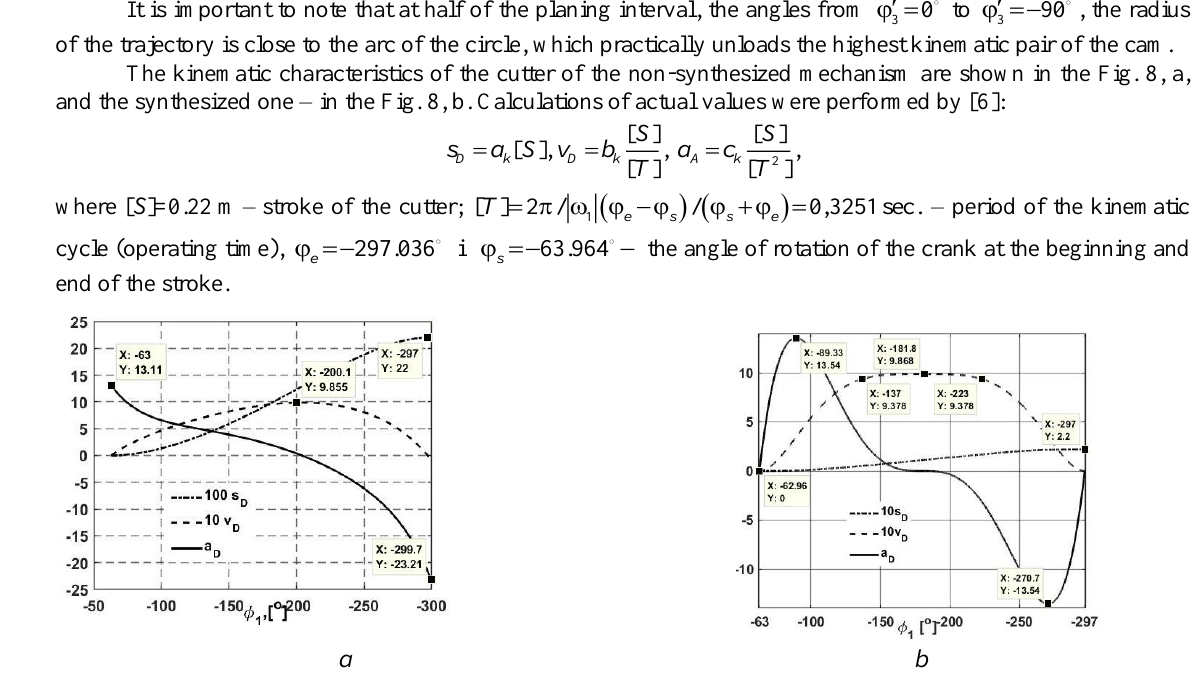
Fig. 8. Kinematic characteristics of the cutter: a - not synthesized and b - synthesized